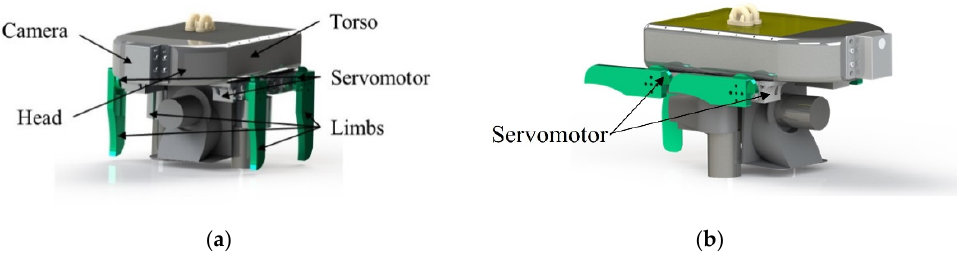
Figure 5. Illustration of Salamandra motion: ( a ) illustration of Salamandra swimming; ( b ) illustration of Salamandra swimming.